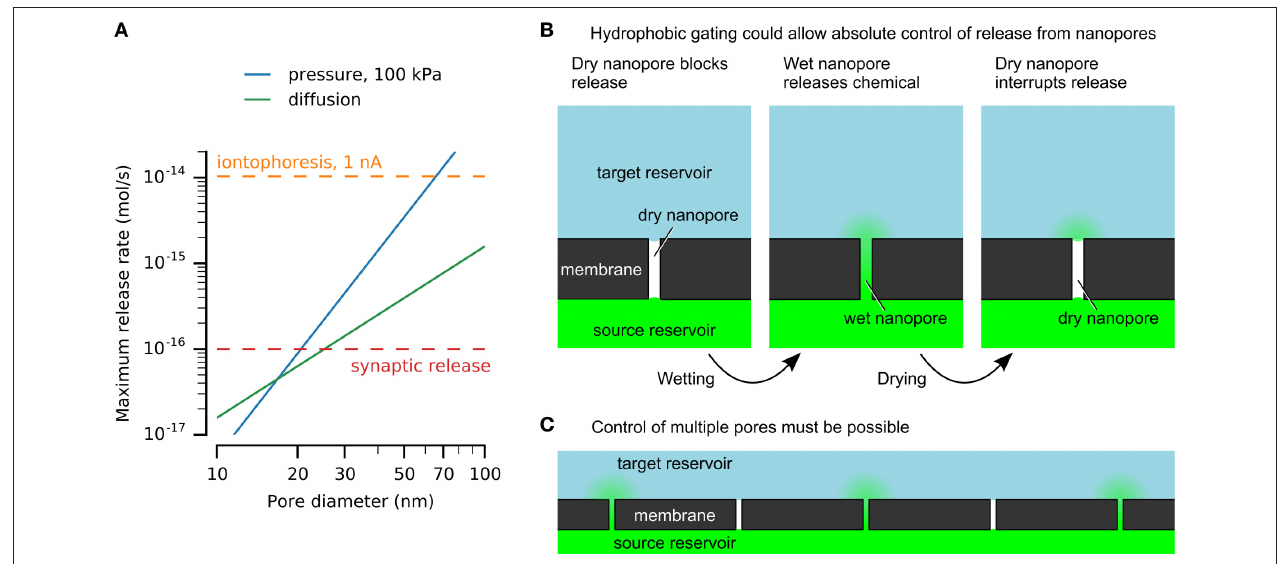
FIGURE 1 | Nanofluidics may enable chemical release similar to vesicular release at synaptic active zones. (A) Nanopores can release physiologically-relevant quantities. Release rates by diffusion and pressure-driven flow through nanopores with varying diameters are compared here to an upper estimate for release from a single synaptic active zone and iontophoresis. Calculations used a pore length of 500nm, source concentration of 100 mM, and diffusivity of 10 − 9 m 2 /s. (B) Hydrophobic gating of nanopores may enable absolute control of chemical release without leakage by diffusion. (C) Simultaneous control of large numbers of pores will be necessary for